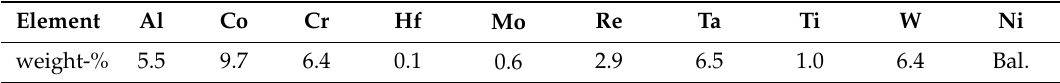
Table 1. Chemical composition of ERBO / 1 in weight-%.